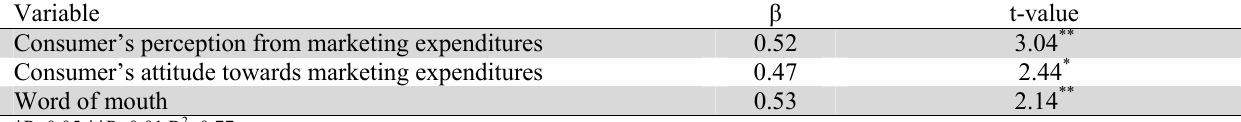
The results of the effects independent variables with brand awareness as dependent variable Variable β Consumer’s perception from marketing